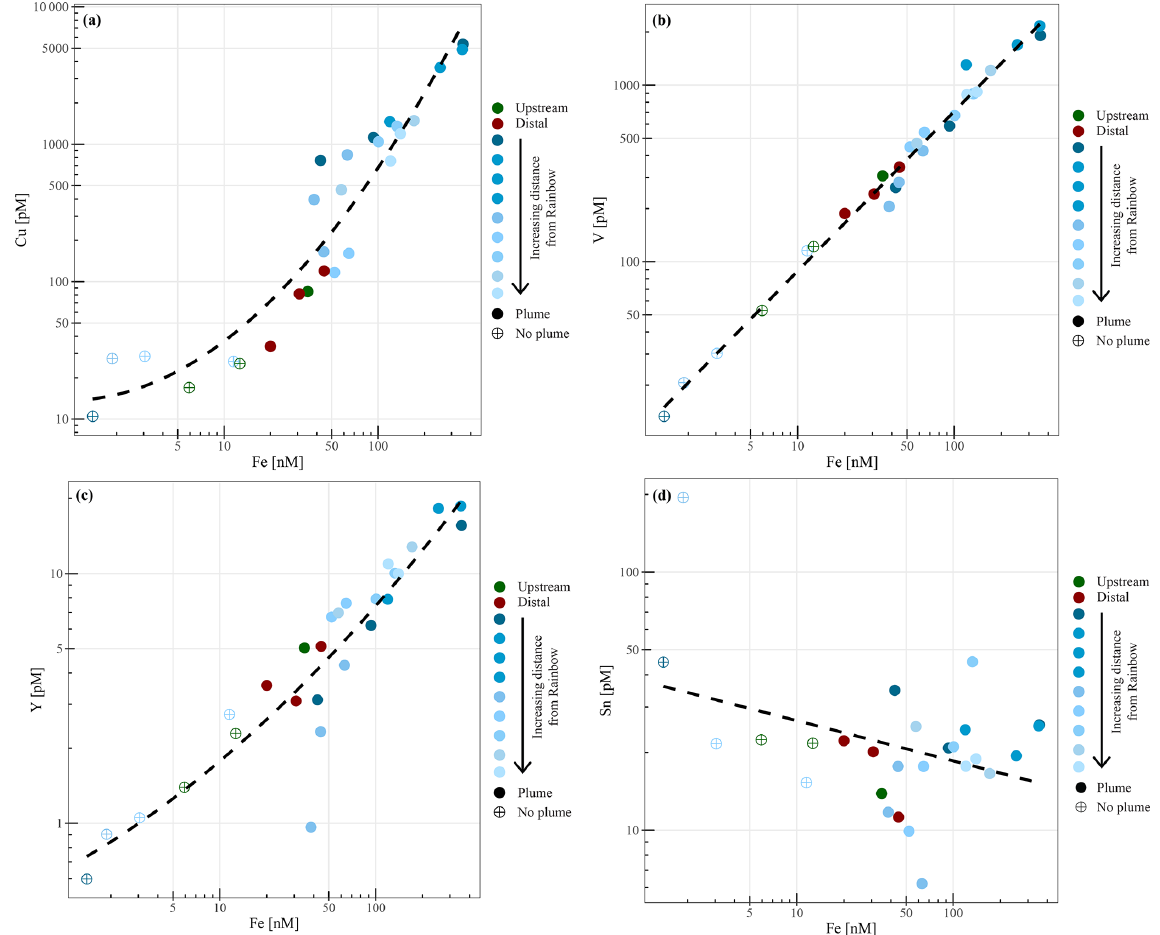
Figure 6. Relationships between molar concentrations of particulate copper (a) , vanadium (b) , yttrium (c) and tin (d) to iron.